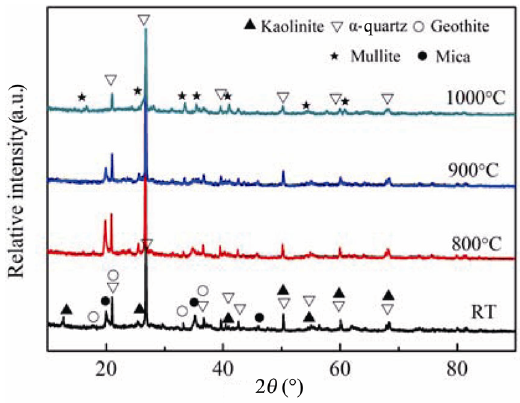
Fig. 4 XRD patterns of the coal gangue microspheres before and after high temperature treatment.